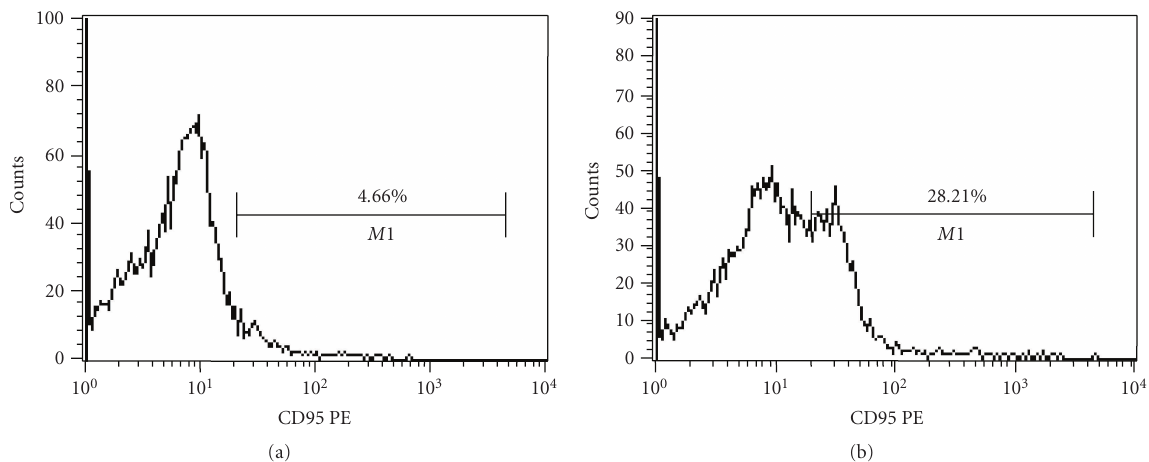
Figure 6: (a) CD95 expression by the normal bone marrow cells. (b) Increased CD95 expression on the bone marrow cells in aplastic anemia showed a significant high level of apoptosis in the bone marrow cell population in aplastic